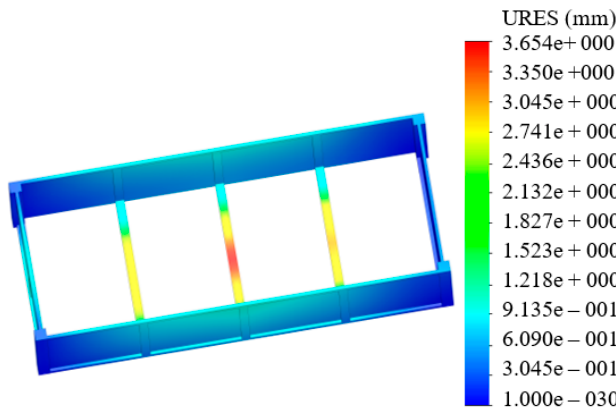
Figure 11. Displacements in the units of a